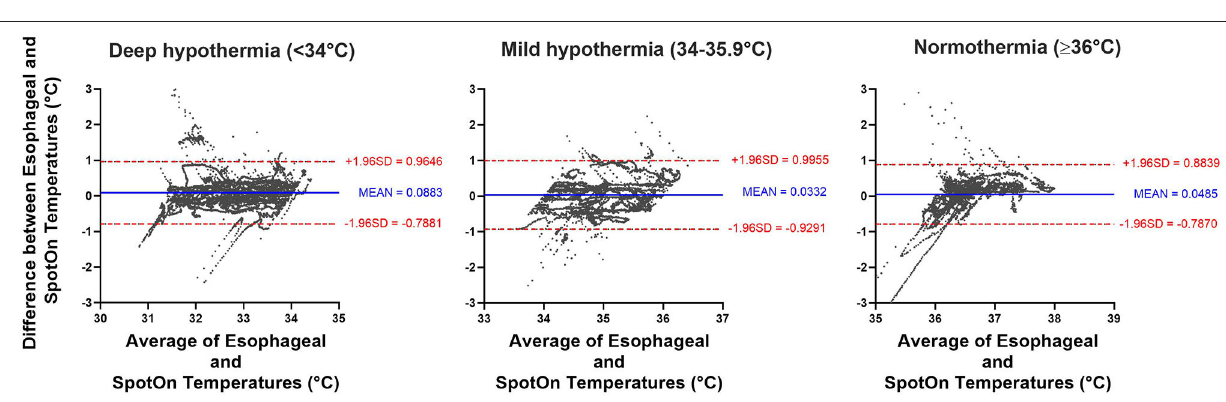
FIGURE 5 | Bland-Altman analysis comparing SpotOn TM and esophageal temperature probes in different temperature ranges, including deep hypothermia ( < 34 ◦ C), mild hypothermia (34–35.9 ◦ C), and normothermia ( ≥ 36 ◦